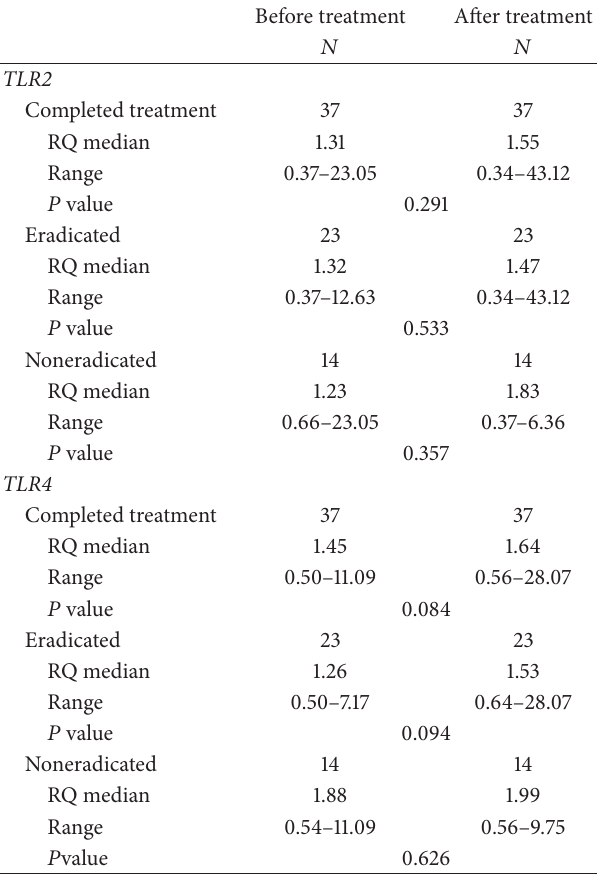
Table 2: Comparison of TLR2 and TLR4 mRNA relative expression levels before and after H. pylori eradication